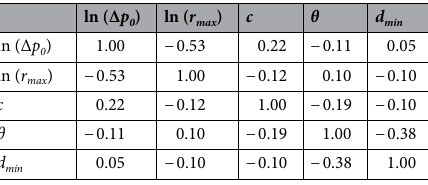
Table 2. Correlation coefficients among typhoon key parameters for improved typhoon simulation method.